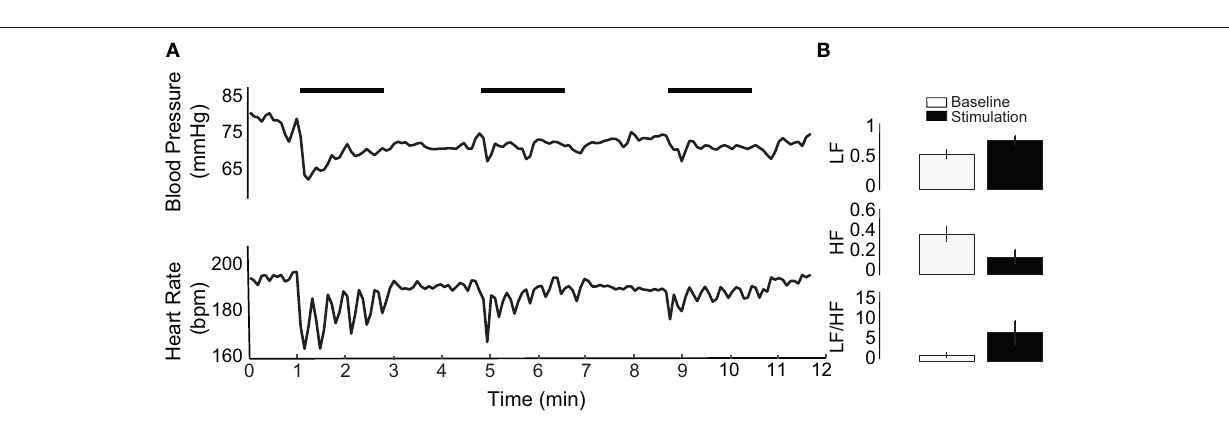
FIGURE 7 | Electrical stimulation of the PC. (A) An example of electrical stimulation in one of three stimulated rats. IR stimulation periods are indicated by horizontal black bars. (B) Shows HRV of the electrically stimulated rat in (A) , averaged over three stimulation periods. LF increases, HF decreases, and the LF/HF ratio increases with electrical stimulation of the